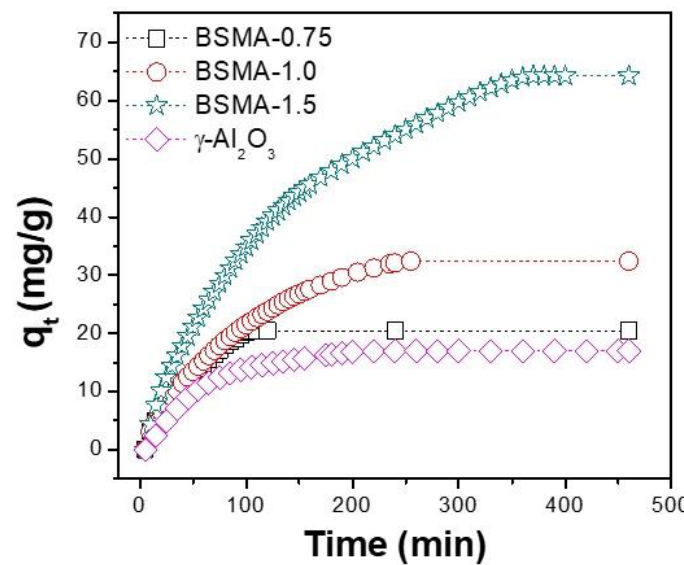
Figure 6. Adsorption performance results of commercial gamma alumina and the synthesized BSMA samples.